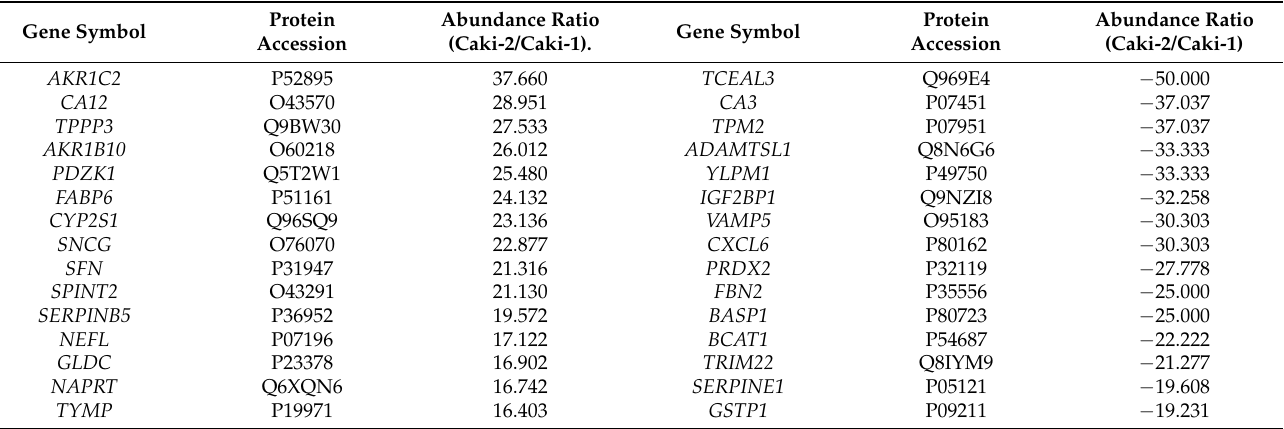
Table 1. Comparative quantitative proteomic analysis between Caki-1 and Caki-2 cells. The top 15 proteins which were upregulated in Caki-2 (down-regulated in Caki-1) have positive expression values. The top 15 proteins downregulated in Caki-2 (upregulated in Caki-1) have negative expression